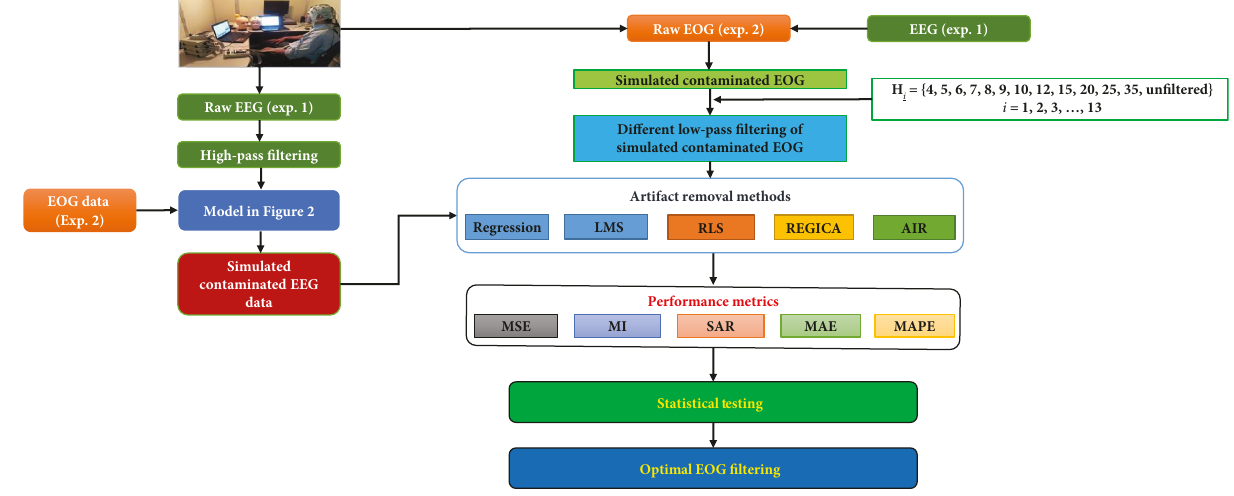
Figure 1: Schematic plan of the study.